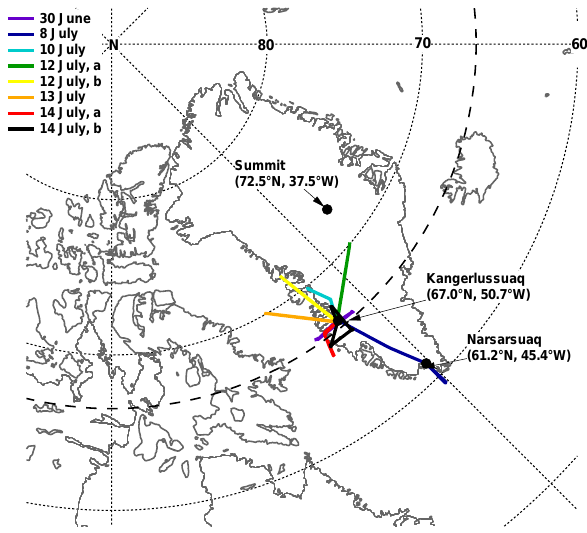
Fig. 1. POLARCAT-France summer experiment 2008 flight tracks involving AMS measurements covering altitudes from sea level to 7.6km. The research aircraft, ATR-42, was based in Kangerlus- suaq,